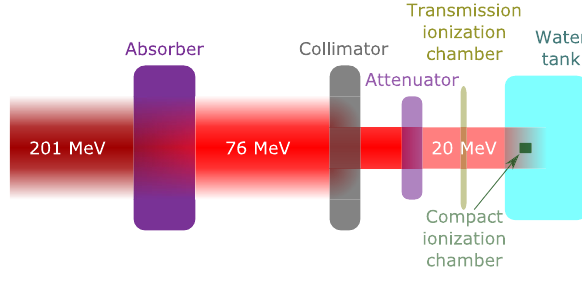
FIG. 5. Schematic of the TIC calibration setup.